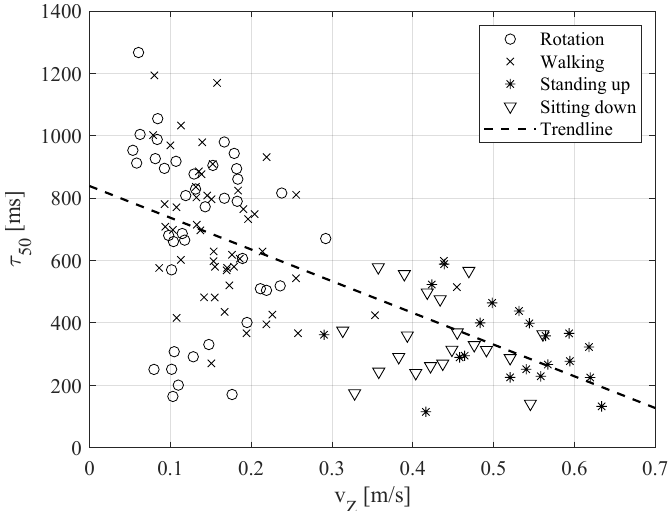
Figure 6. Relation between coherence time and peak amplitude of Fourier transform of linear acceleration in local Z direction (metric (c), parameter